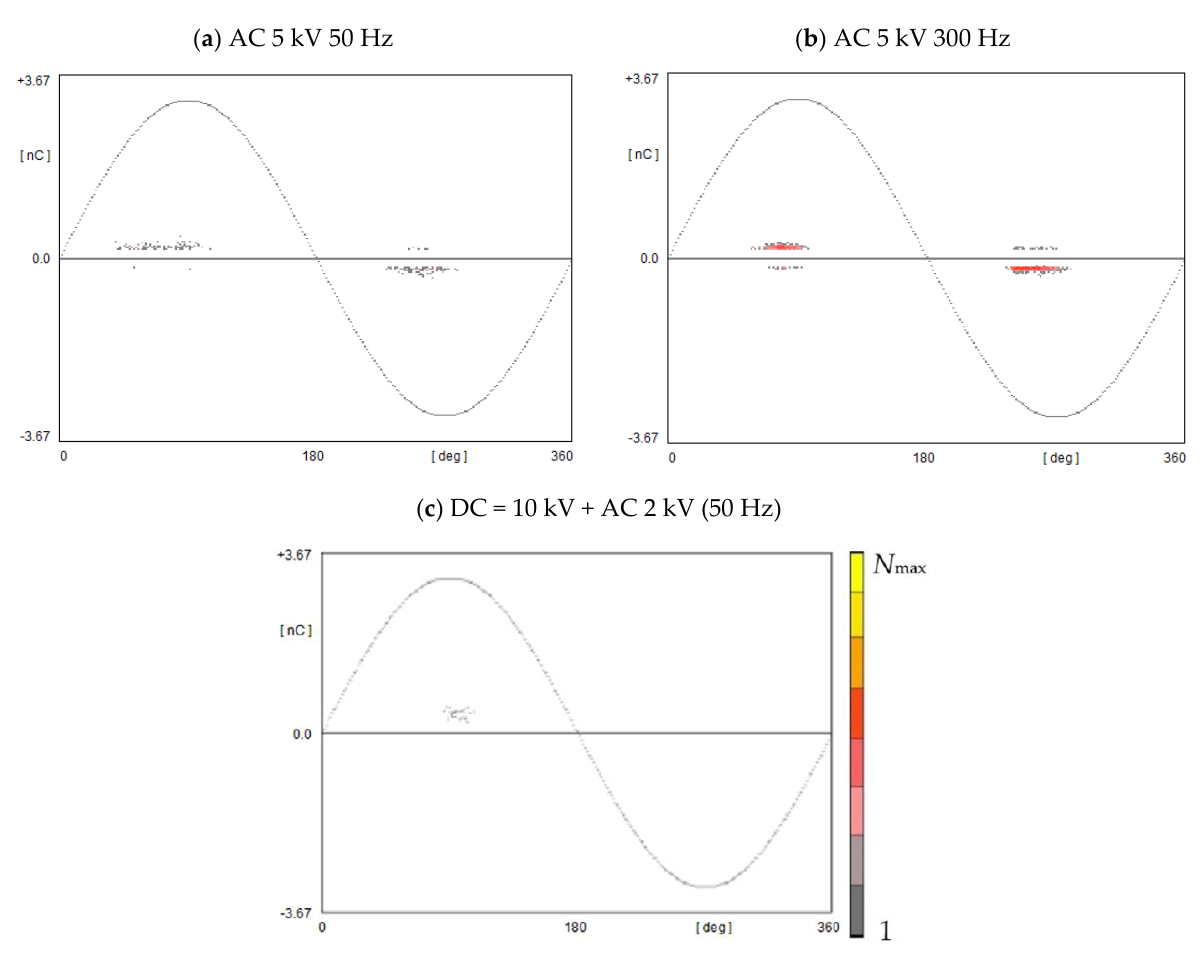
Figure 3. PRPD patterns acquired at inception voltage: ( a ) AC 50 Hz, ( b ) pure AC 300 Hz, ( c ) mixed DC 10 kV + AC 50 Hz 2 kV. (The scale for the number of pulses N presented on the right side of ( c ) is the same as for the other PRPD patterns presented in the article).